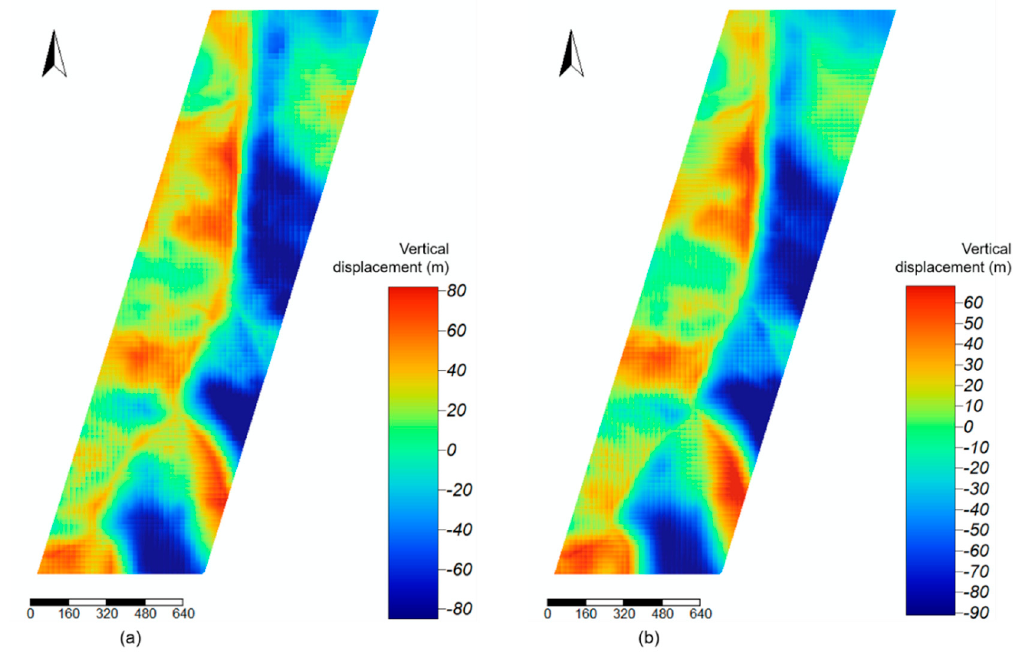
Figure A1. DTMs for a subset of the test site, generated from: (a) ASTER data, at the original 21.0m resolution, (b) SRTM data, at the original 21.0m resolution and (c) ALS data, interpolated at 0.5m resolution using the Natural Neighbour algorithm.